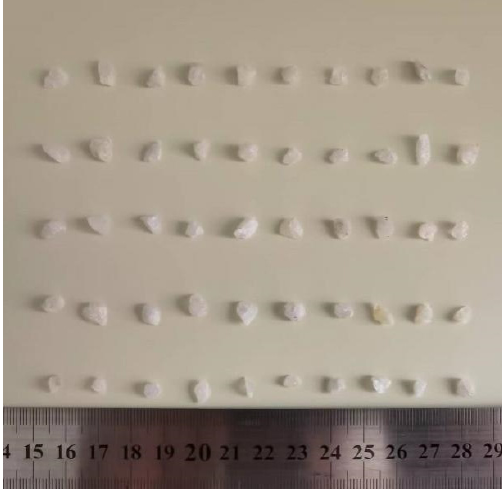
Figure 4. Physical properties of natural sand.